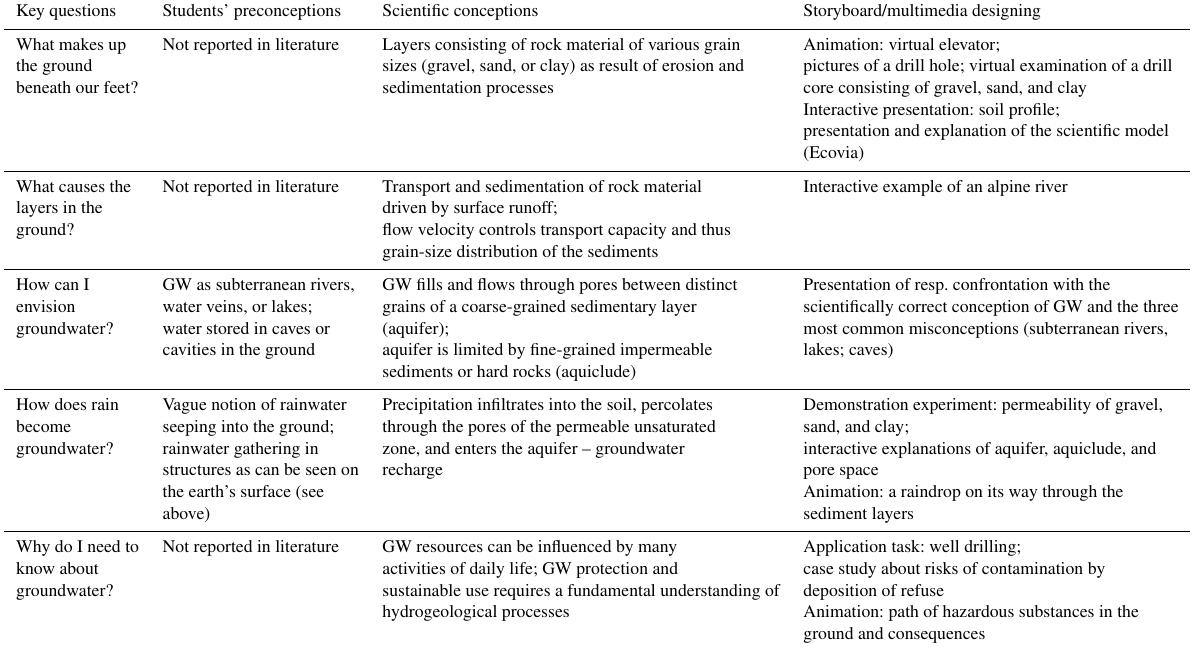
Table 1. Key questions in the designing process with regard to groundwater (GW) preconceptions (as far as reported in literature), scientific conceptions, and multimedia